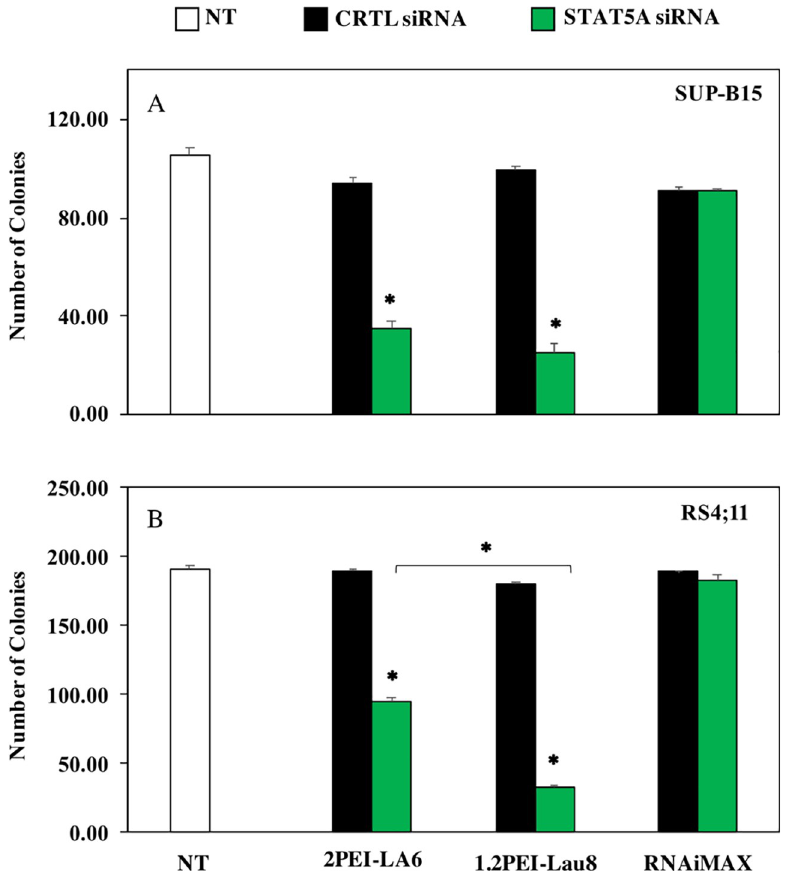
Fig 4. Effects of transfection with CTRL/STAT5A siRNA/polymer complexes on colony formation in leukemic cell lines. Colony counts were performed two weeks after treatment at concentration of 60 nM and at polymer:siRNA ratio of 6, (RNAiMAX:siRNA ratio: 2.5:1). (A) Total number of colonies formed by SUP-B15 cells (A) and RS4;11 cells (B). (n = 3) � : p � 0.05.